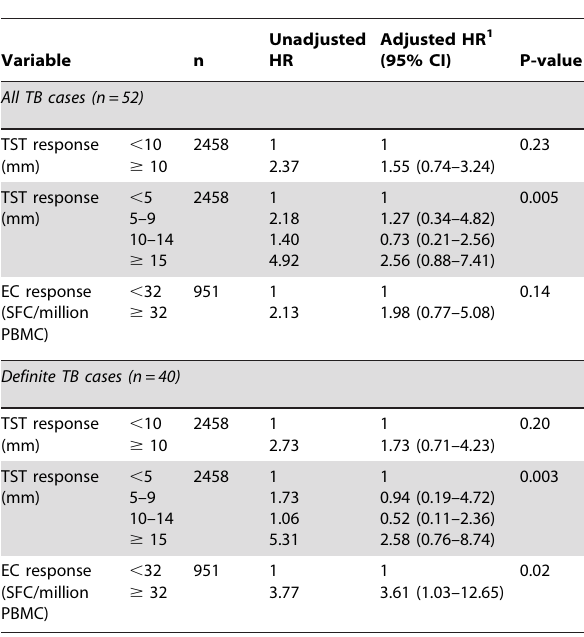
Table 5. Multivariable analysis of time to TB episode (all TB cases and definite TB cases only); unadjusted and adjusted hazard ratios, 95% CI and P-values, separately for TST and EC